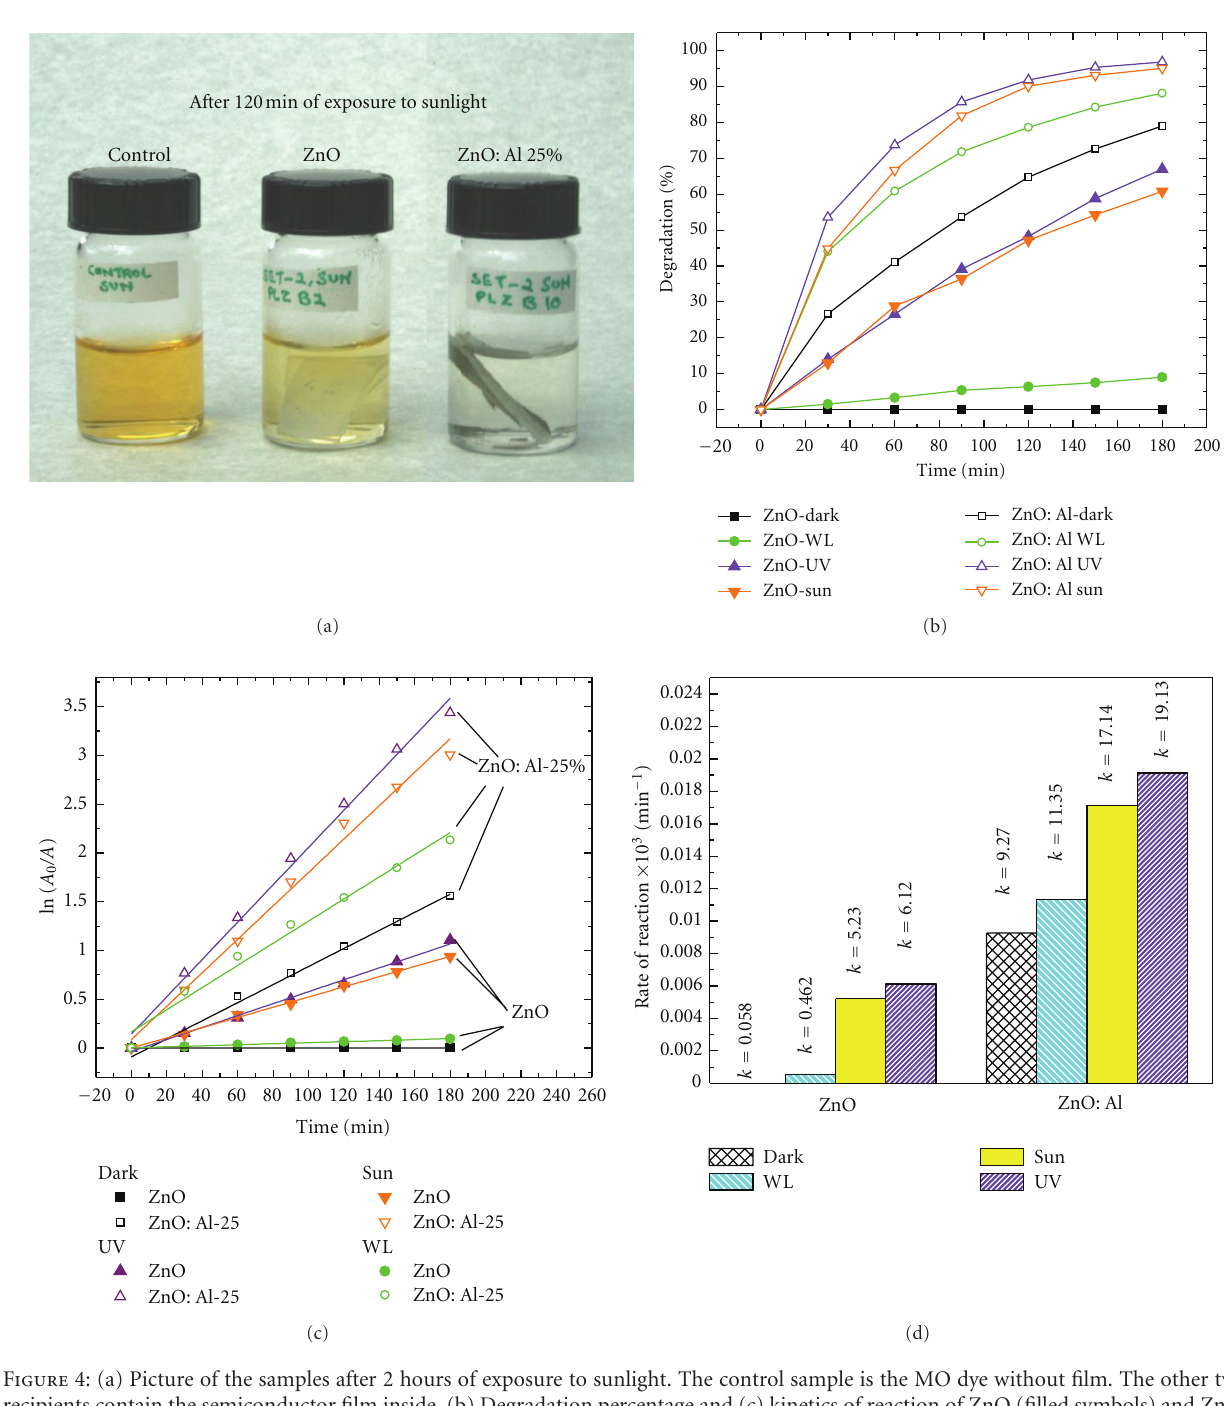
Figure 4: (a) Picture of the samples after 2 hours of exposure to sunlight. The control sample is the MO dye without film. The other two recipients contain the semiconductor film inside. (b) Degradation percentage and (c) kinetics of reaction of ZnO (filled symbols) and ZnO: Al (open symbols) under di ff erent illuminations: dark (black), artificial white light (green), ultraviolet light (purple), and sunlight (orange). (d) Rate of reaction of the ZnO and ZnO: Al films under di ff erent illumination sources and darkness for comparison.